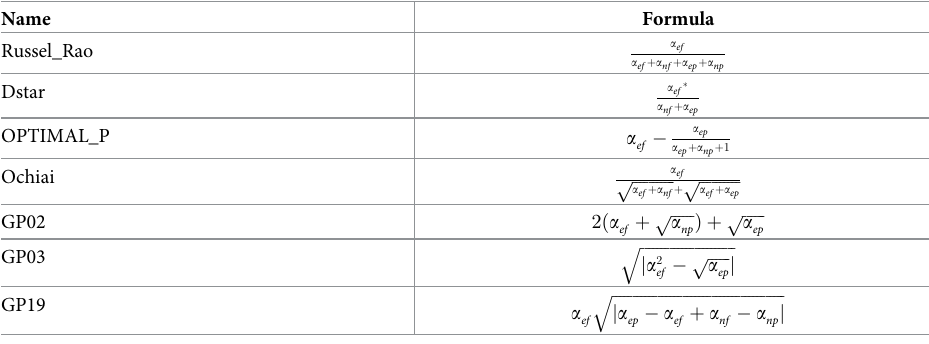
Table notes Phasellus venenatis, tortor nec vestibulum mattis, massa tortor interdum felis, nec pellentesque metus tortor nec nisl. Ut ornare mauris tellus, vel dapibus arcu suscipit